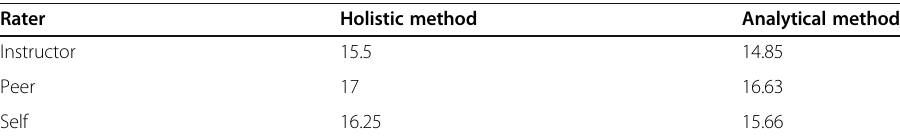
Table 3 Integrated task mean scores